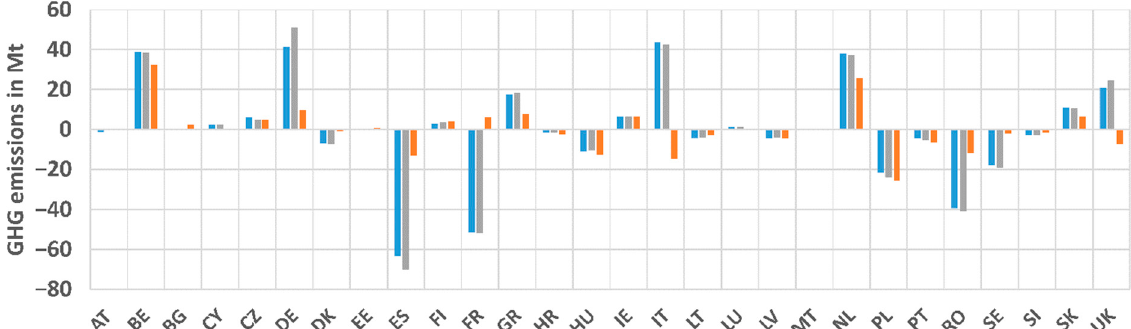
Figure 10. Total greenhouse gas emissions by country in 2050.